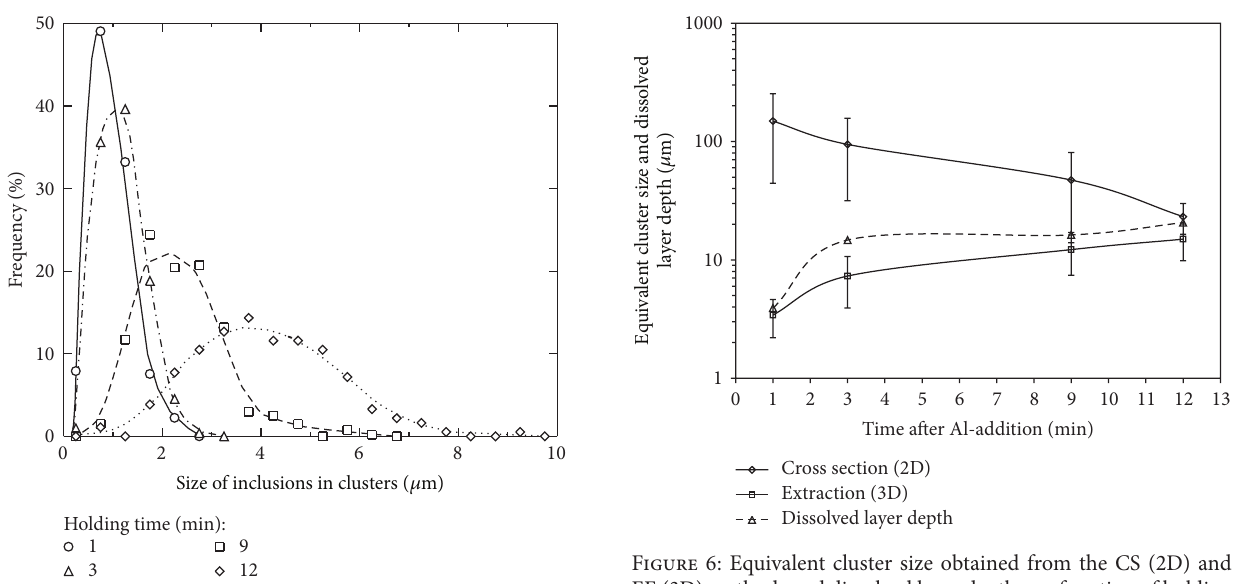
Figure 4: Particle size distributions of inclusions in clusters in stainless steel samples obtained from EE method.